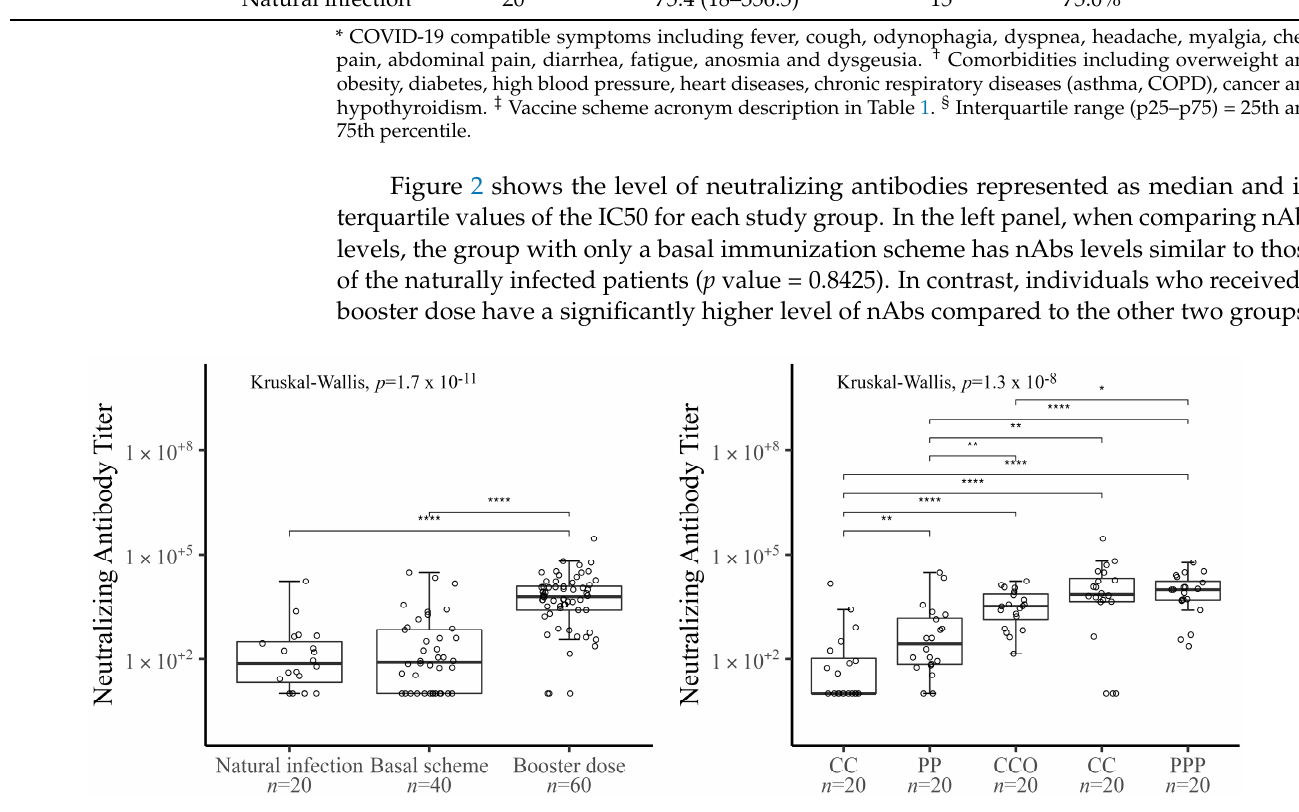
Figure 2. All samples were plotted as individuals points and graphed the median and interquartile for both panels. Left panel shows a comparison of nAbs titers between natural infection ( n = 20), two dose schemes ( n = 40), and booster dose ( n = 60). The right panel shows a comparison of nAbs between the different vaccination schemes: CC (CoronaVac CoronaVac), PP (Pfizer Pfizer), CCO (CC plus Oxford AstraZeneca), CCP (CC plus Pfizer), PPP (Triple Pfizer), with n = 20 for each group. Symbols *, **, and **** denote statistically significant differences among the comparison groups; p ≤ 0.05, p ≤ 0.01 and p ≤ 0.0001, respectively. The statistical differences were performed with Kruskal-Wallis test, and a p -value < 0.05.